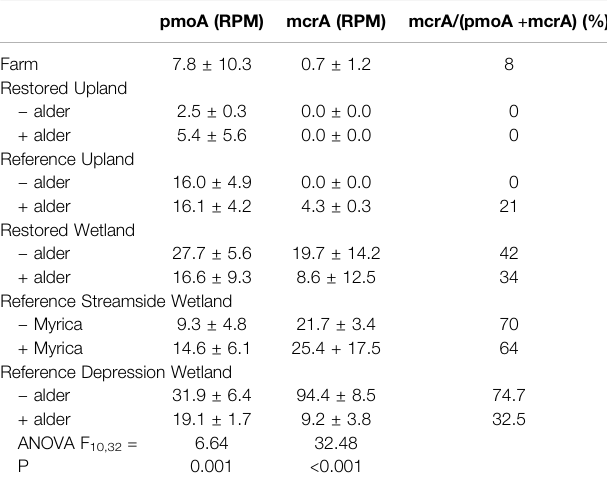
TABLE 6 | Occurrence of genes associated with either methane oxidation genes (pmoA)ormethanogenesis(mcrA)andnormalizedratioofgenesfrom11sites investigated in this study.